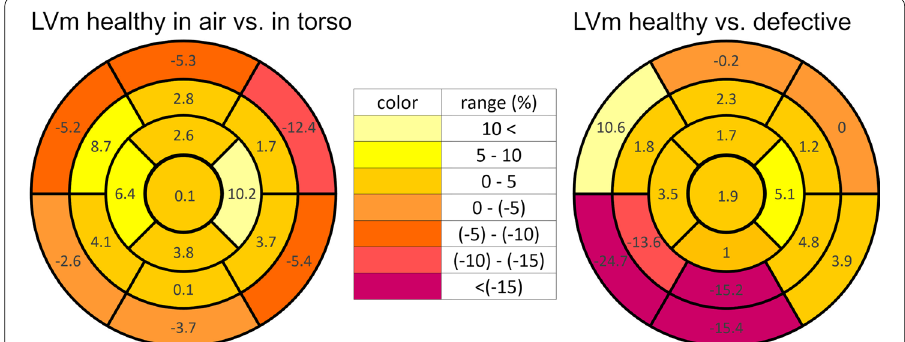
Fig. 10 Polar maps of the relative percentage differences for different LVm phantom measurements. Left panel: results of the LVm healthy phantom "in air” vs. "in torso” comparison. Right panel: results of the LVm healthy vs. LVm defective phantom